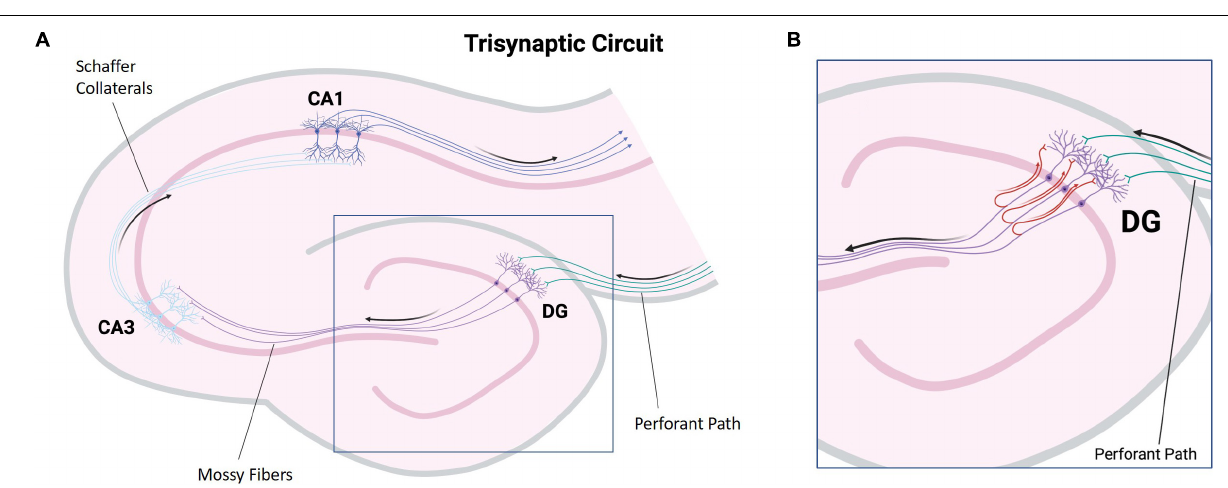
FIGURE 2 | Illustration of major hippocampal connections. (A) A simplified diagram of the tri-synaptic circuit of the hippocampus. The entorhinal cortex provides synaptic input to the granule cells of the dentate gyrus via the perforant path (green). The granule cells project to CA3 pyramidal neurons via mossy fibers (purple). CA3 pyramidal neurons project to CA1 pyramidal neurons via Schaffer collaterals (light blue). CA1 pyramidal neuron axons carry hippocampal output (dark blue). (B) A diagram depicting mossy fiber sprouting. In hippocampal sclerosis associated mossy fiber sprouting, mossy fibers display aberrant growth and project back to the molecular layer of the dentate gyrus containing the apical dendrites of the granule cells (red). (DG, dentate gyrus: CA, Cornu ammonis) (Created with